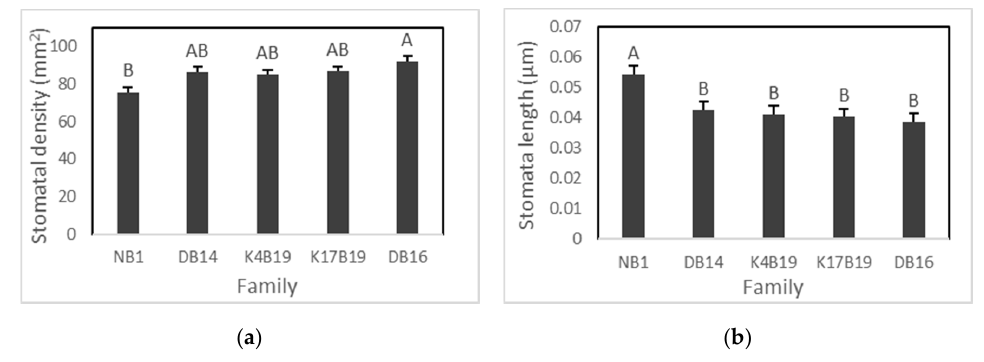
Figure 5. Variation of stomatal density ( a ) and size ( b ) among Senegalia senegal families. Different letters on bars mean significant differences among families at p < 0.05.